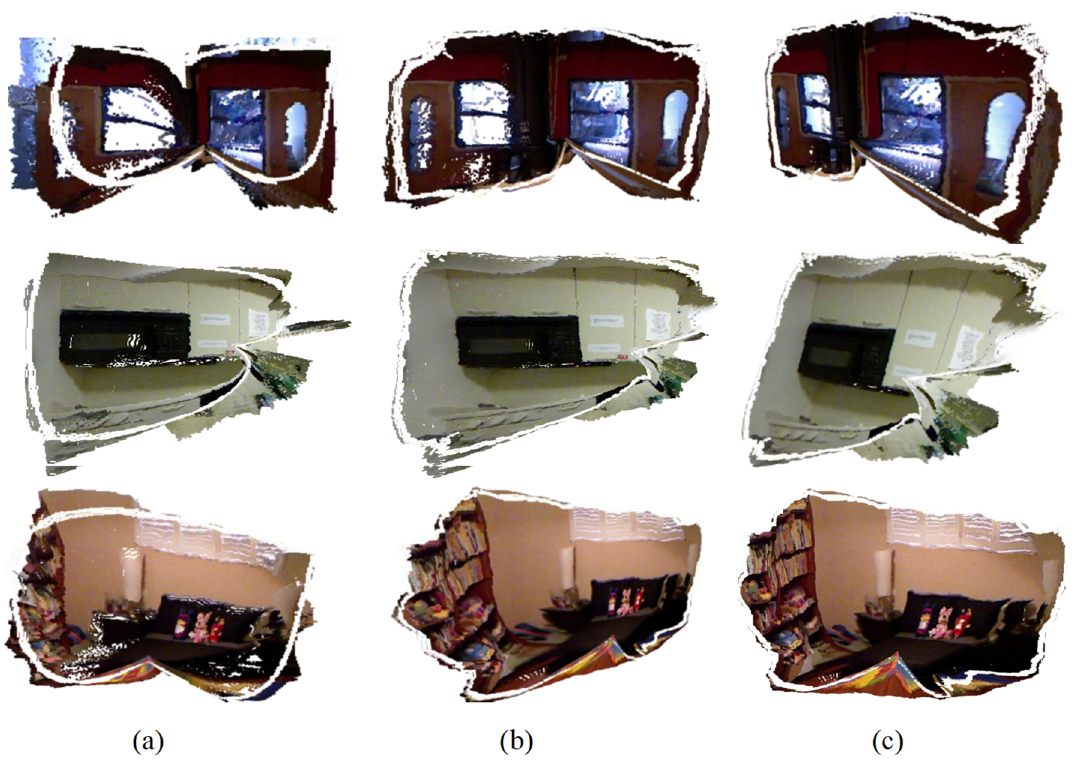
Table 1 Comparison results on Make3D dataset